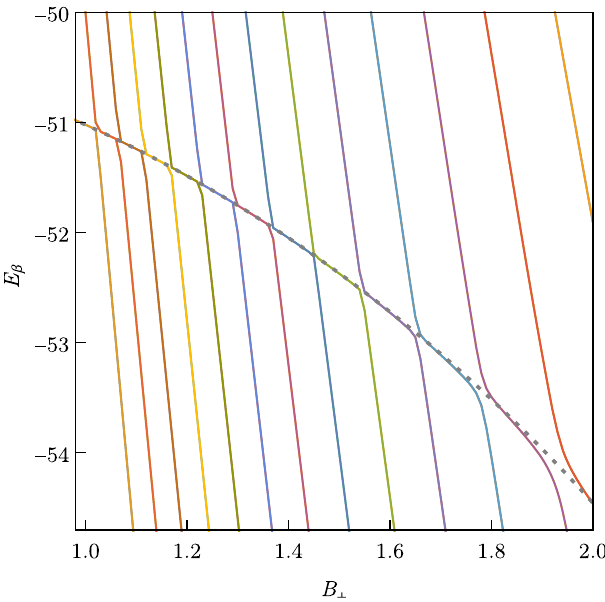
FIG. 6. Solid lines show the dependence on the transverse field B ⊥ of the eigenvalues E β of the nonlinear eigenvalue problem with Hamiltonian H ð E Þ for the case of n ¼ 50 and M ¼ 2 . The plot shows the repeated avoided crossing between the two systems of eigenvalues. One system (colored lines) corresponds to the eigenvalues of the transverse-field (driver) Hamiltonian P − B σ k → 0 . The second system of n H in the limit H ⊥ x D ¼ cl k ¼ 0 FIG. 7. The solid red line shows the dependence of the total eigenvalues corresponds to the energies of the two marked states weight Q vs transverse field B ⊥ for n ¼ 40 . Vertical black and in the limit B ⊥ → 0 . The splitting of the eigenvalues is exponen- blue lines, respectively, depict the locations of p -even and p -odd tially small in n and not resolved in the plot. The asymptotic resonances B ⊥ ¼ B ⊥ defined in the text. The total weight Q p 0 Þ ð 0 Þ expressions (36) and (37) for the two eigenvalues E ð undergoes sharp decreases in the vicinity of even resonances. For 1 ; 2 ¼ E − n for all neglecting the tunneling splitting and setting E ð z p < 5 , the resonance regions are so narrow that dips in Q are not j Þ ¼ j ∈ ½ 1 ; M (cid:2) are shown with a dashed gray line. seen. The width of the regions grows steeply with p